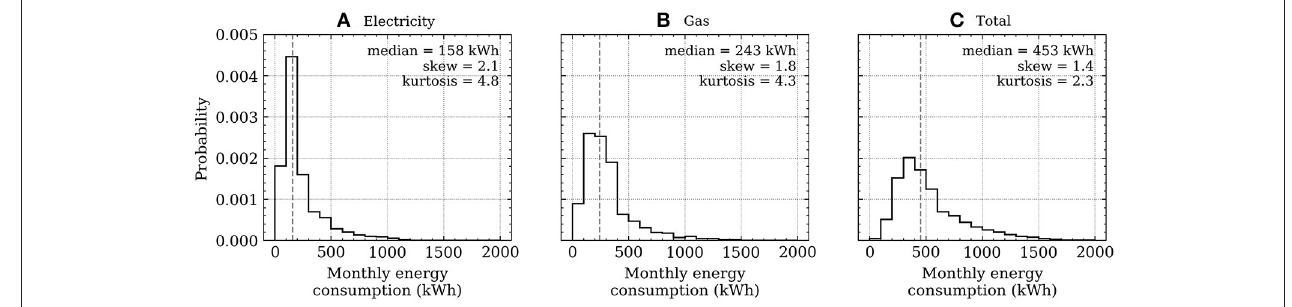
FIGURE 3 | Normalized histogram (solid line) and median (dashed line) of monthly consumption of (A) electricity, (B) gas, and (C) total energy for urban households in Mexico (sample size = 17,850).